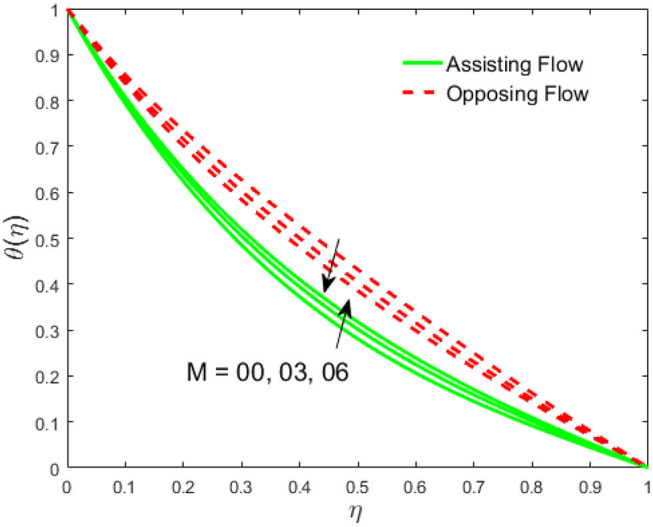
Impact of M on θ(η).